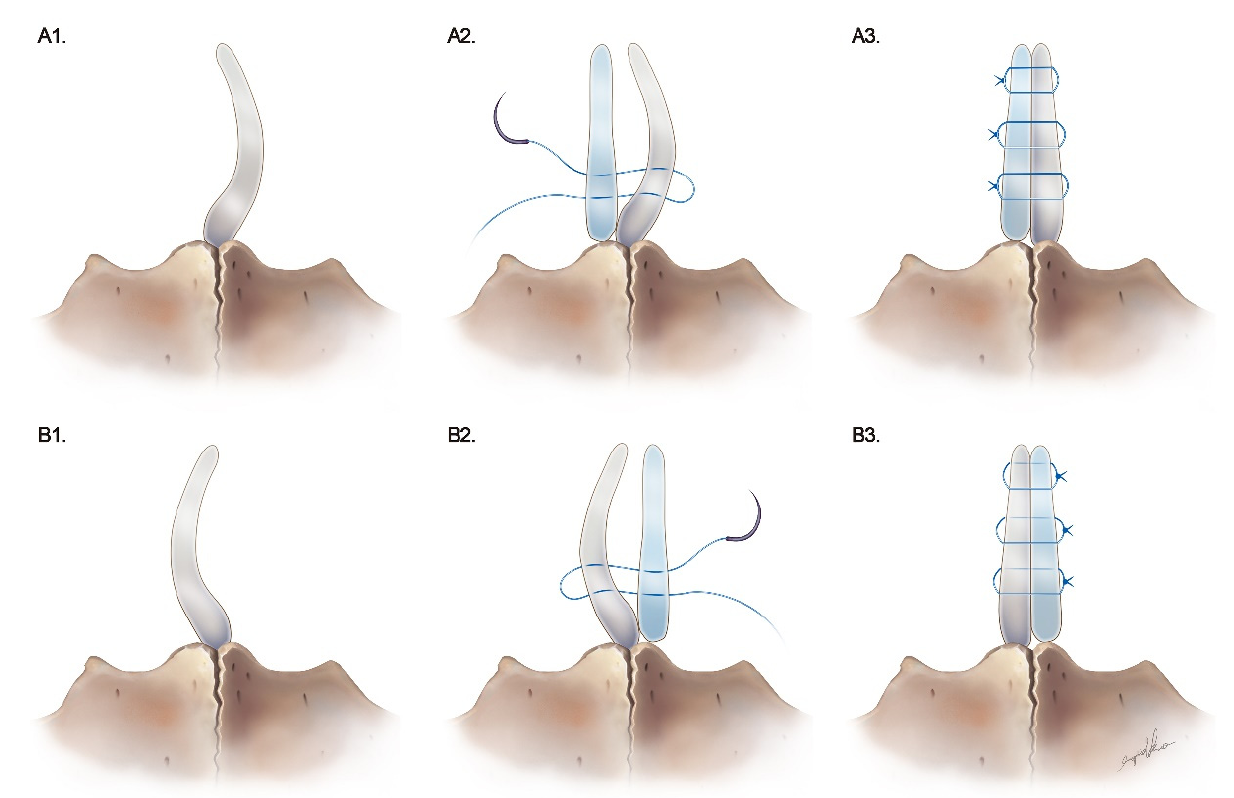
Figure 2. Schematic illustration of a cartilaginous batten graft with suture techniques.